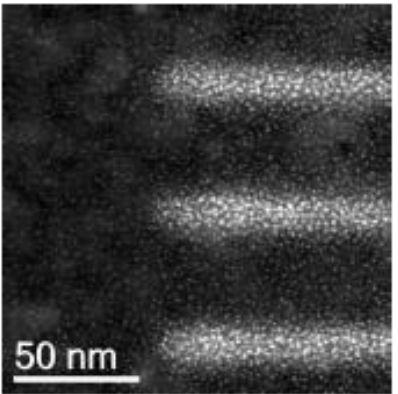
Figure 1. High angle annular dark field (HAADF) image, taken at 80 keV, of dense platinum focused electron beam-induced deposition (FEBID) lines deposited on a 20 nm silicon nitride membrane coated with 20 nm of sputtered silicon and imaged in the transmission electron microscope (TEM). The statistics of the deposition become more evident from the grains visible all the way to the line edges and beyond, giving rise to diffuse deposit in between the lines (private communication M. Scotuzzi and D. Ovchinnikov).